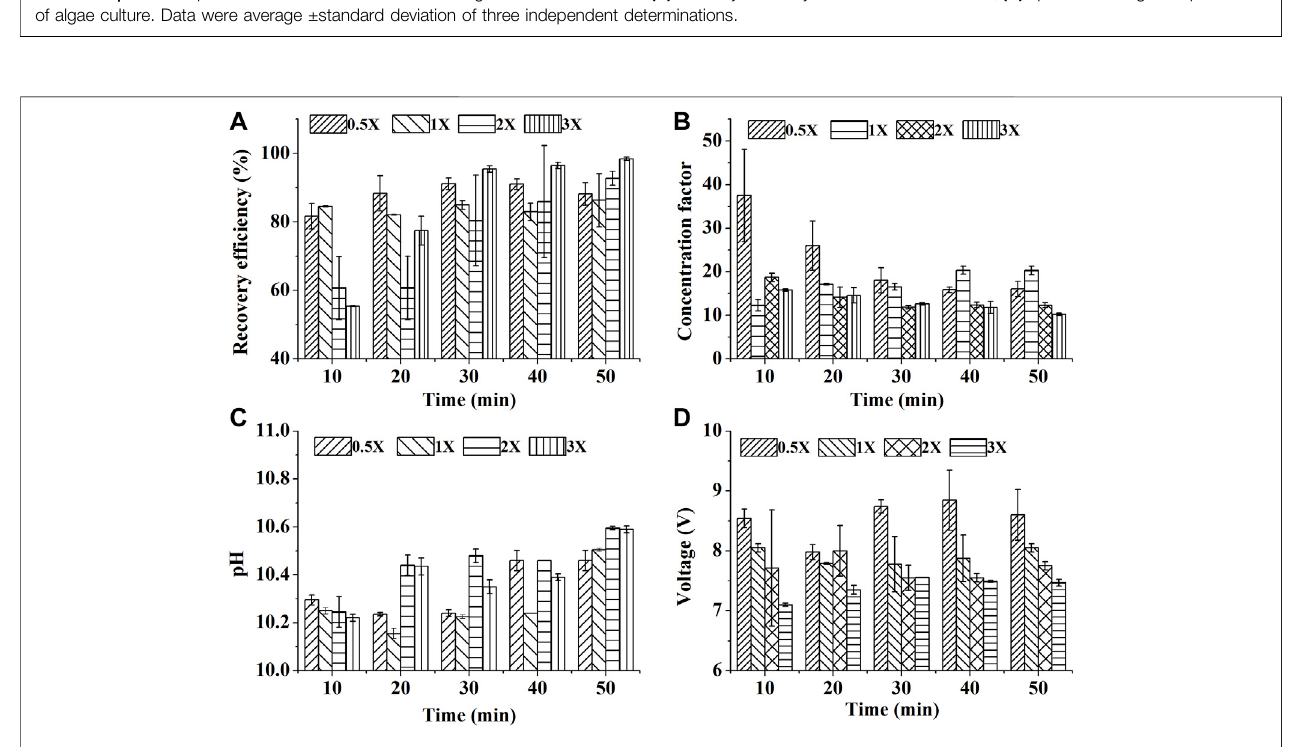
Frontiers in Bioengineering and Biotechnology |